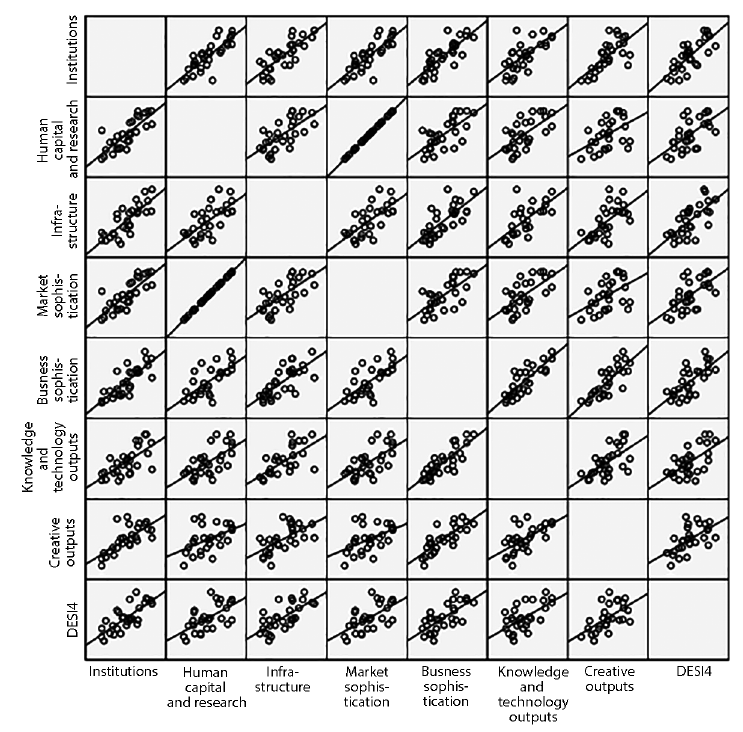
Figure A1. The bivariate links between DESI4 and each pillar of GII and the bivariate links between the GII